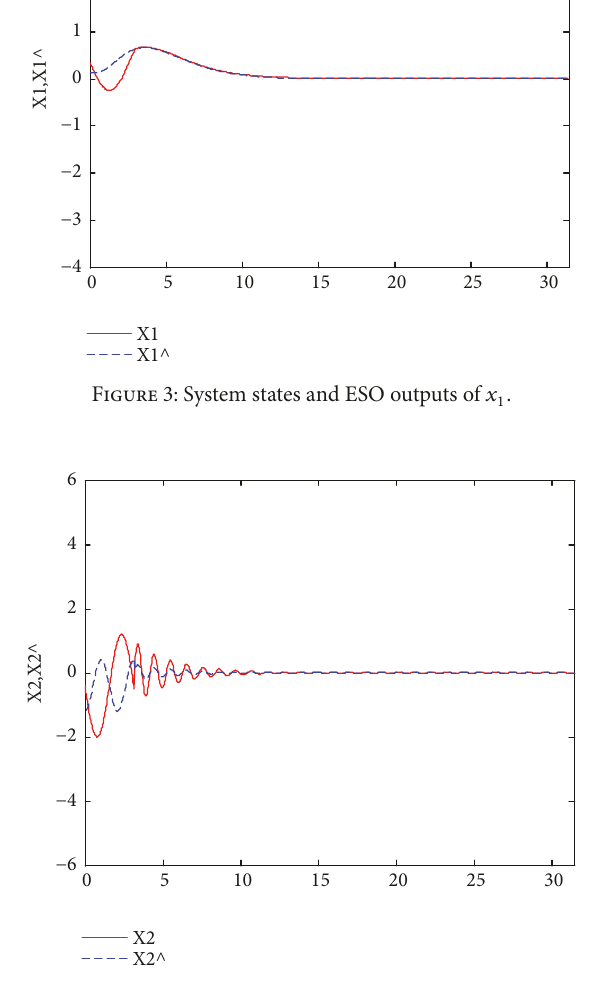
Figure 7: The convergence of the scaled ESO estimation error 𝜂 𝑖